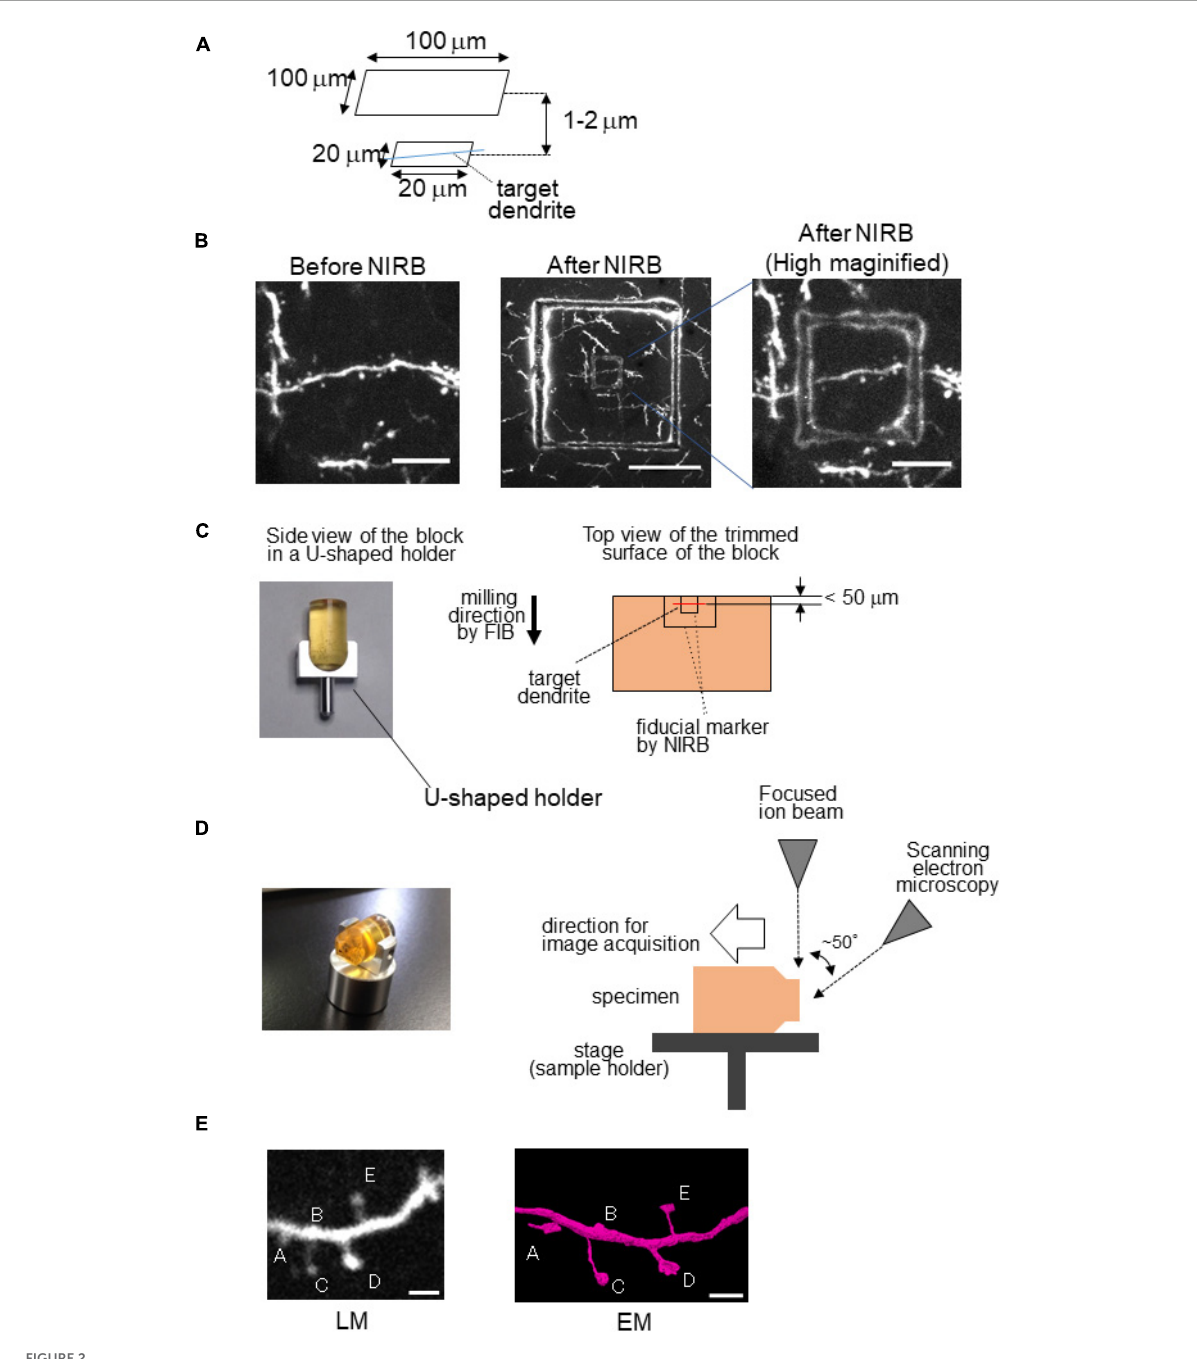
FIGURE2 Near-infrared branding (NIRB) as a fiducial marker for CLEM. Example of NIRB marking in a fixed brain section for the 3D reconstruction of a target dendrite. (A) NIRB scheme for marking a target dendrite. (B) High-magnification images of the dendrite from the cerebral cortex of Thy1-EYFP-H mouse before (left) and after NIRB (middle, right). This mark can be easily visualized via light microscopy from its autofluorescence. Scale bars: 10 µ m (left and middle) and 50 µ m (right). (C) Block trimming of NIRB samples. (Left) Side view of the sample in a U-shaped holder (HV-8; Microstar, Japan) before trimming. (Right) Scheme for trimming the sample block for FIB-SEM imaging. The target dendrite should be located close to the edge of the block ( < 100 mm). (D) Observation of the sample block using FIB-SEM. (Left) Sample block after trimming in the U-shaped block holder (HV-8). The sample block is turned until the surface of the trimmed block is parallel to the focused ion beam (right) configuration of the dual-beam FIB/SEM and sample set. (E) (Left) Example of a two-photon microscopic image of a cortical dendrite in vivo . Scale bar = 2 µ m. (Right) 3D reconstructed image of the target dendrite by EM. Modified from Takahashi-Nakazato et al. (2019) with